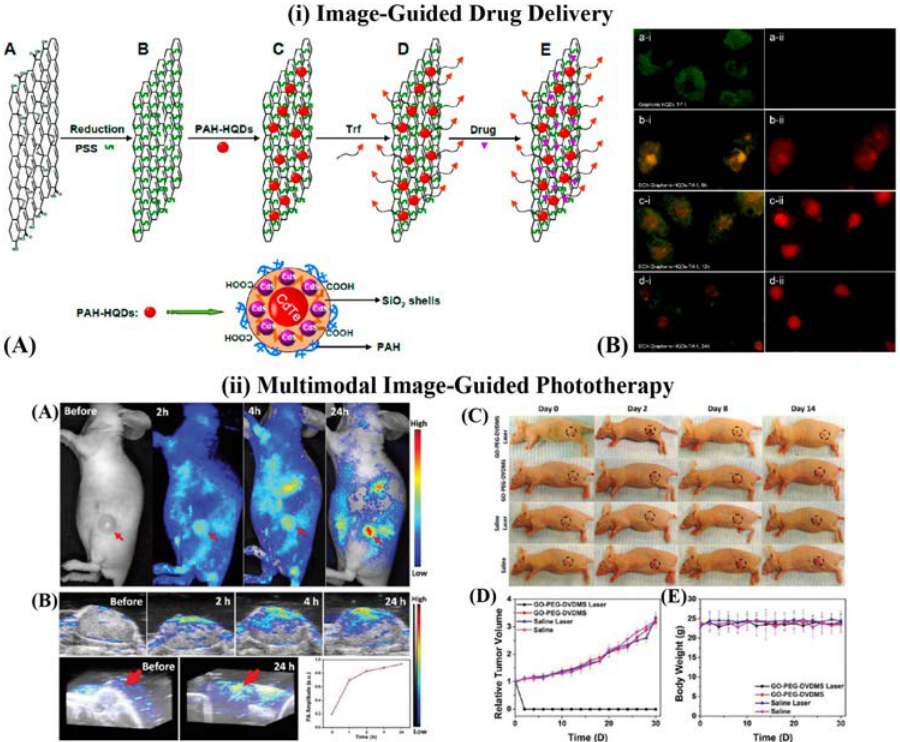
Fig. 7. Graphene-based nanotheranostic platforms. (i) Imaging guided drug delivery. (A) Preparation of Water Dispersible DOX-Graphene-HQDs-Trf (B) Fluorescent microscopic images of HeLa cells directly labeled by graphene-HQDs-Trf-1 for 4h (a), and DOX-graphene-HQDs-Trf-1 for 6h (b), 12h (c), and 24h (d). ((i), °uorescent images by blue light excitation; (ii), °uorescent images by green light excitation.) Reproduced with permission from Ref. 141. Copyright 2013 American Chemical Society. (ii) Multimodal imaging guided phototherapies. (A) In vivo °uorescence images and (B) ultrasound/photoacoustic images and quantitative analysis of PA signal of PC9 bearing mice treated with GO-PEG-DVDMS (GO-PEG 1mg kg (cid:1) 1 , DVDMS 2mg kg (cid:1) 1 ) at 2, 4 and 24h post-injection. (C) In vivo synergistic therapies of GO- PEG-DVDMS. (A) Representative photos of PC9 tumor-bearing mice from di®erent groups after treat- ment of PDT, PTT or their synergism on day 14. (D) Tumor growth curves of di®erent groups of tumor- bearing mice after di®erent treatments. (E) Body weight curves of PC9 tumor mice after di®erent treatments. Reproduced with permission from Ref. 164. Copyright 2015 Royal Society of Chemistry. (iii) Multimodal imaging guided chemo-phototherapy. (A) Schematic illustration of NIR photothermal en- hanced chemotherapy mechanism of GIAN/DOX complexes. (B) UV – Vis characterization of the DOX- loaded GIANs. Inset: digital photo of the DOX, GIAN, and GIAN/DOX solutions. (C) Fluorescence spectroscopy characterization of the DOX loading e±ciency. (D) Cell viability of MCF-7 cells with and without NIR laser irradiation after incubation with free DOX, GIAN, and GIAN/DOX, respectively. (E) Bright ¯eld microscopy images of trypan blue-stained MCF-7 cells after di®erent NIR photothermal treatments. Scale bar: 50 (cid:2) m. (F) and (G), relative cell viability after treatment with di®erent GIAN concentrations and di®erent 808nm laser irradiation times, respectively. Reproduced with permission from Ref. 166. Copyright 2014 Nature publishing